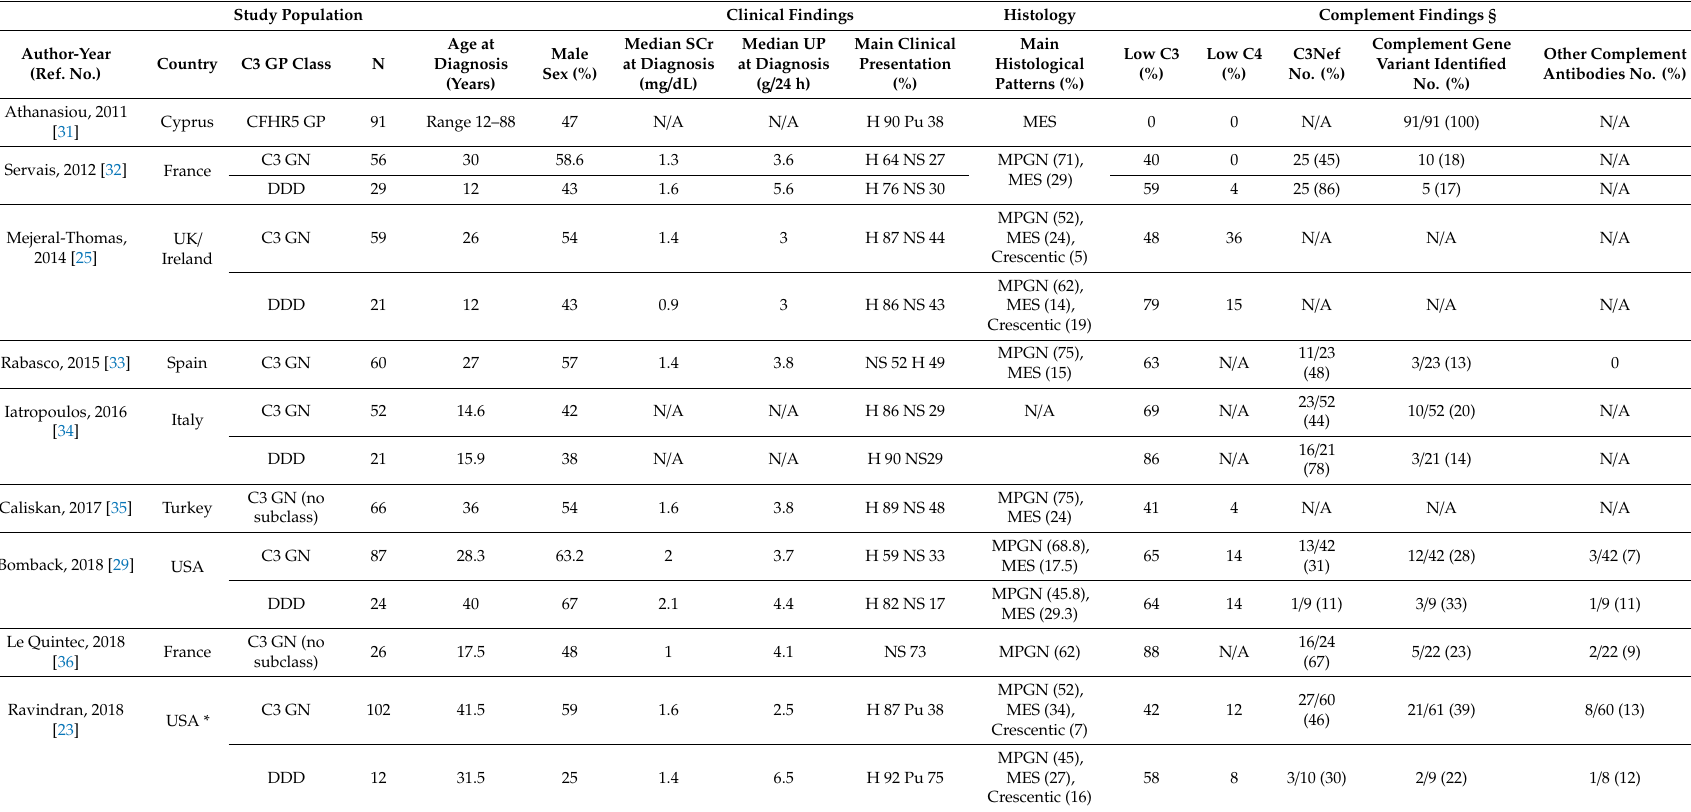
Table 1. Clinical and laboratory characteristics of patients a ff ected by C3 GP enrolled in cohort